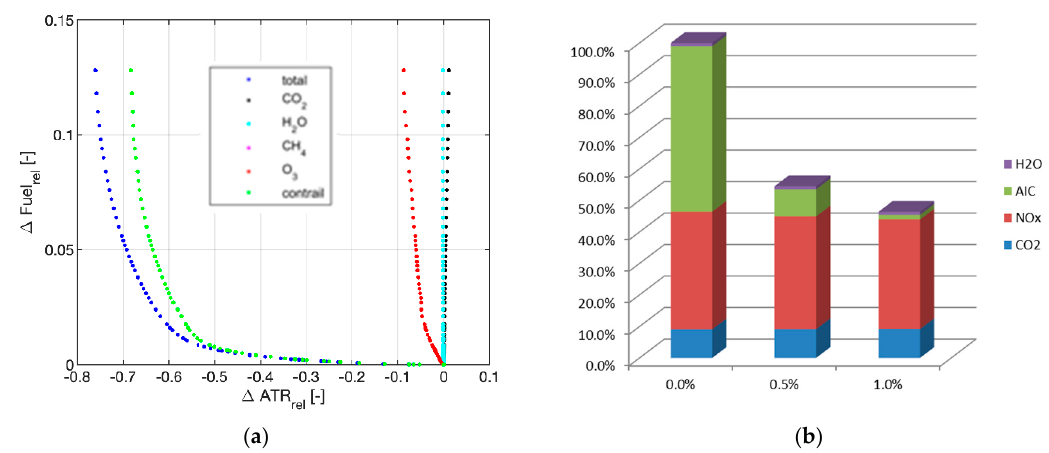
Figure 5. Pareto front with relative climate impact reduction vs. fuel increase ( a ) and mitigation potential, including individual contributions shown for three options: fuel optimal (0.0%), 0.5%, and 1% fuel penalty (%) ( b ) on 18 Decmber 2015 for a European traffic sample of 2000 routes using ATR 20 .